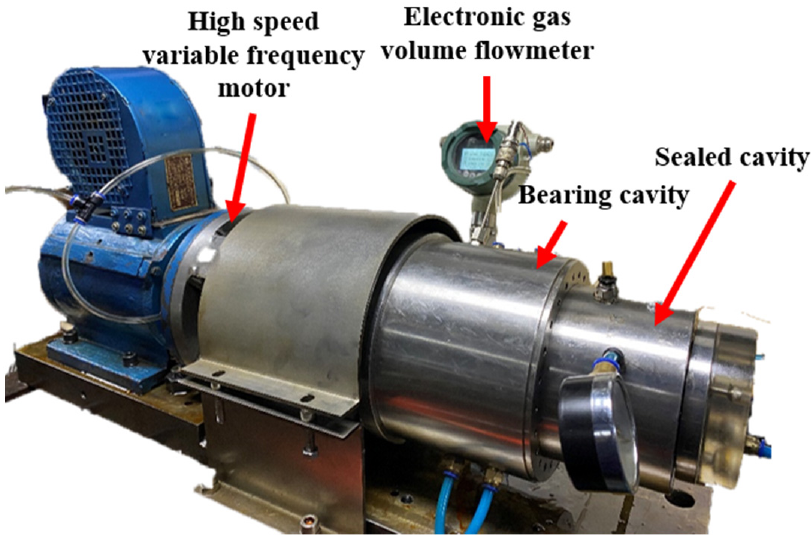
Figure 8. Picture of the test bench.